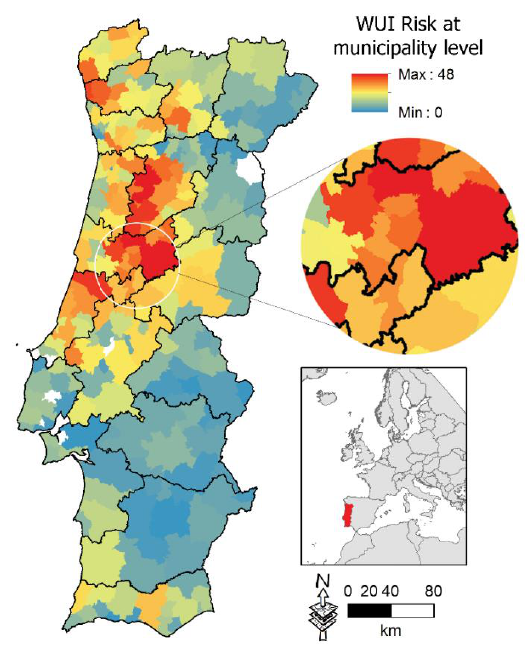
Figure 2. Characterization of wildland urban interface (WUI) fire risk in Portugal at Municipality level (adapted from [4], with the area of the Pedrógão fire highlighted.